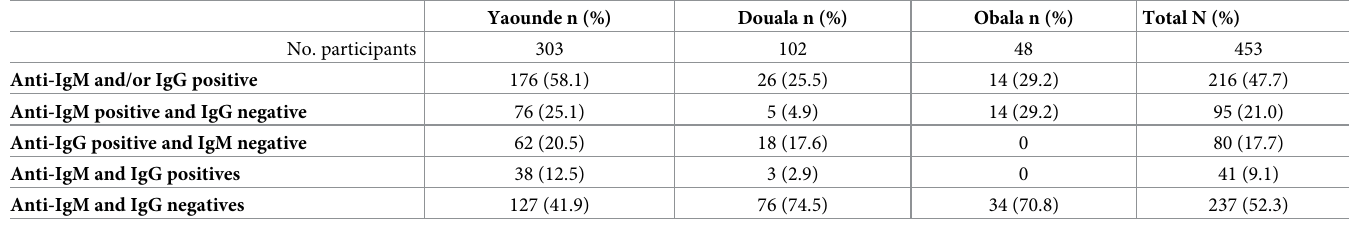
Table 1. Results of detection of specific anti-hepatitis E virus antibodies.